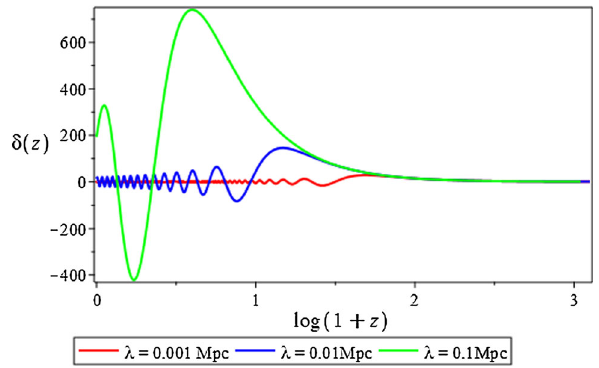
Fig. 2 δ( z ) versus z for Eq. (90) for short-wavelength mode in the radiation-dominated Universe for Λ CDM approach. We consider dif- ferent wave-length ( λ ) limits and 1 = Ω r + Ω Λ for